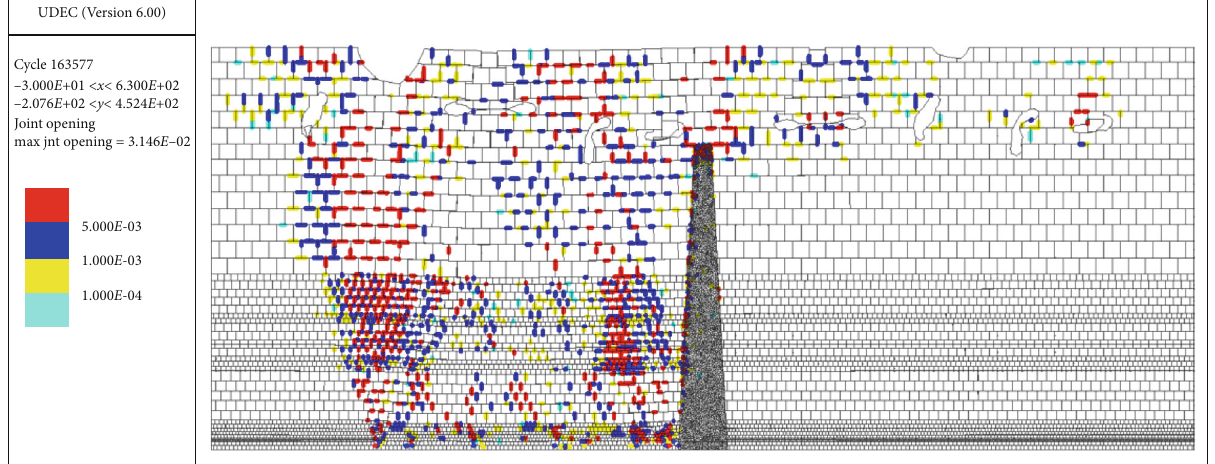
Figure 5: The mining-induced fracture fi eld (the mining distance is 280m).